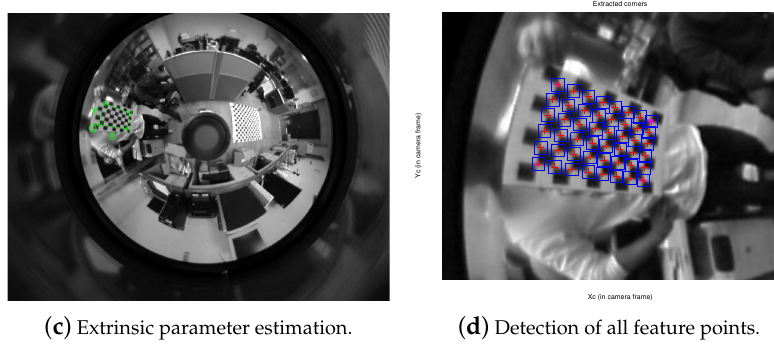
Figure 3. The images captured for omnidirectional camera